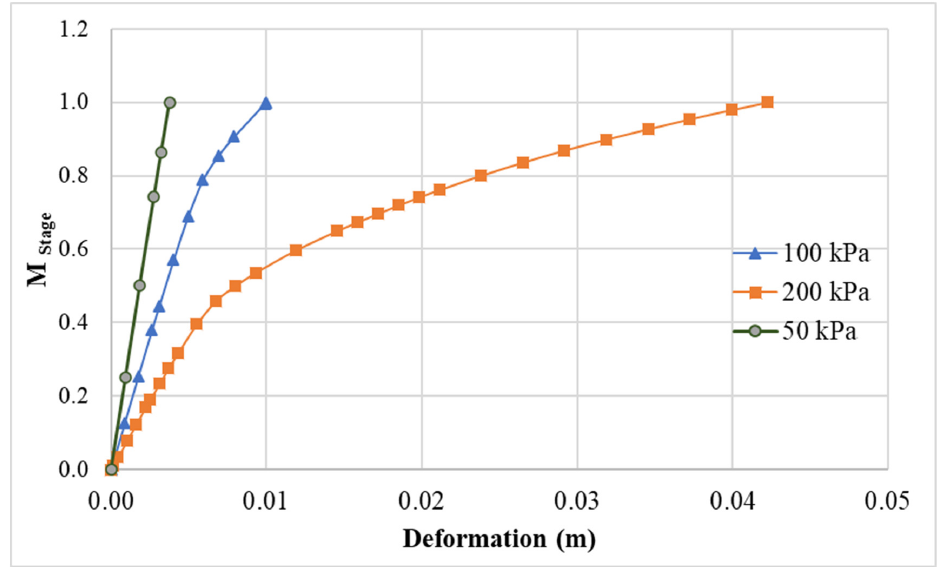
Figure 5. Load–deformation curve.